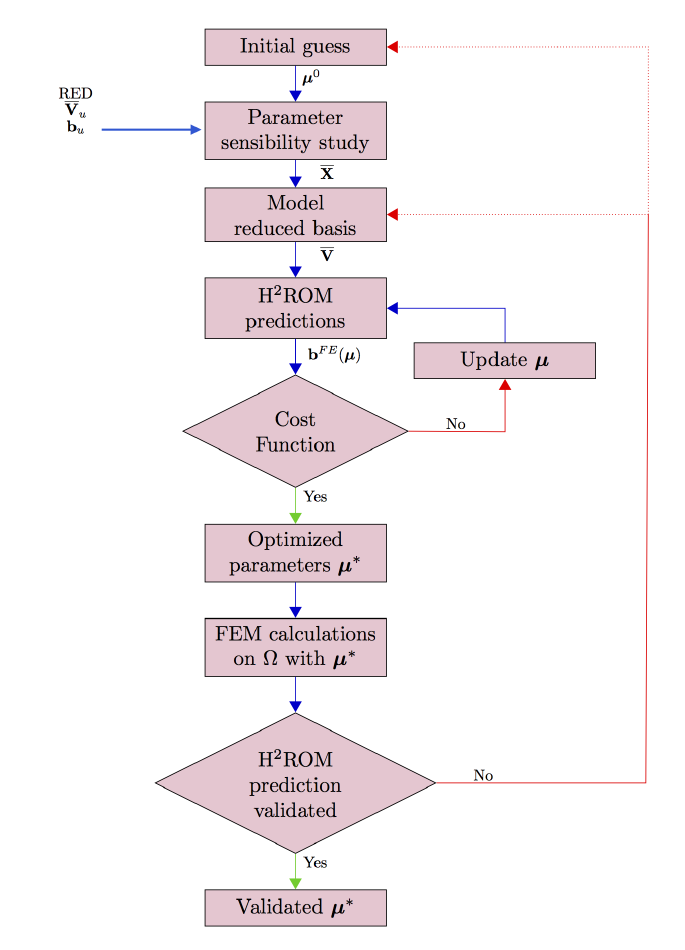
Figure 8. Flowchart of the FEMU-H 2